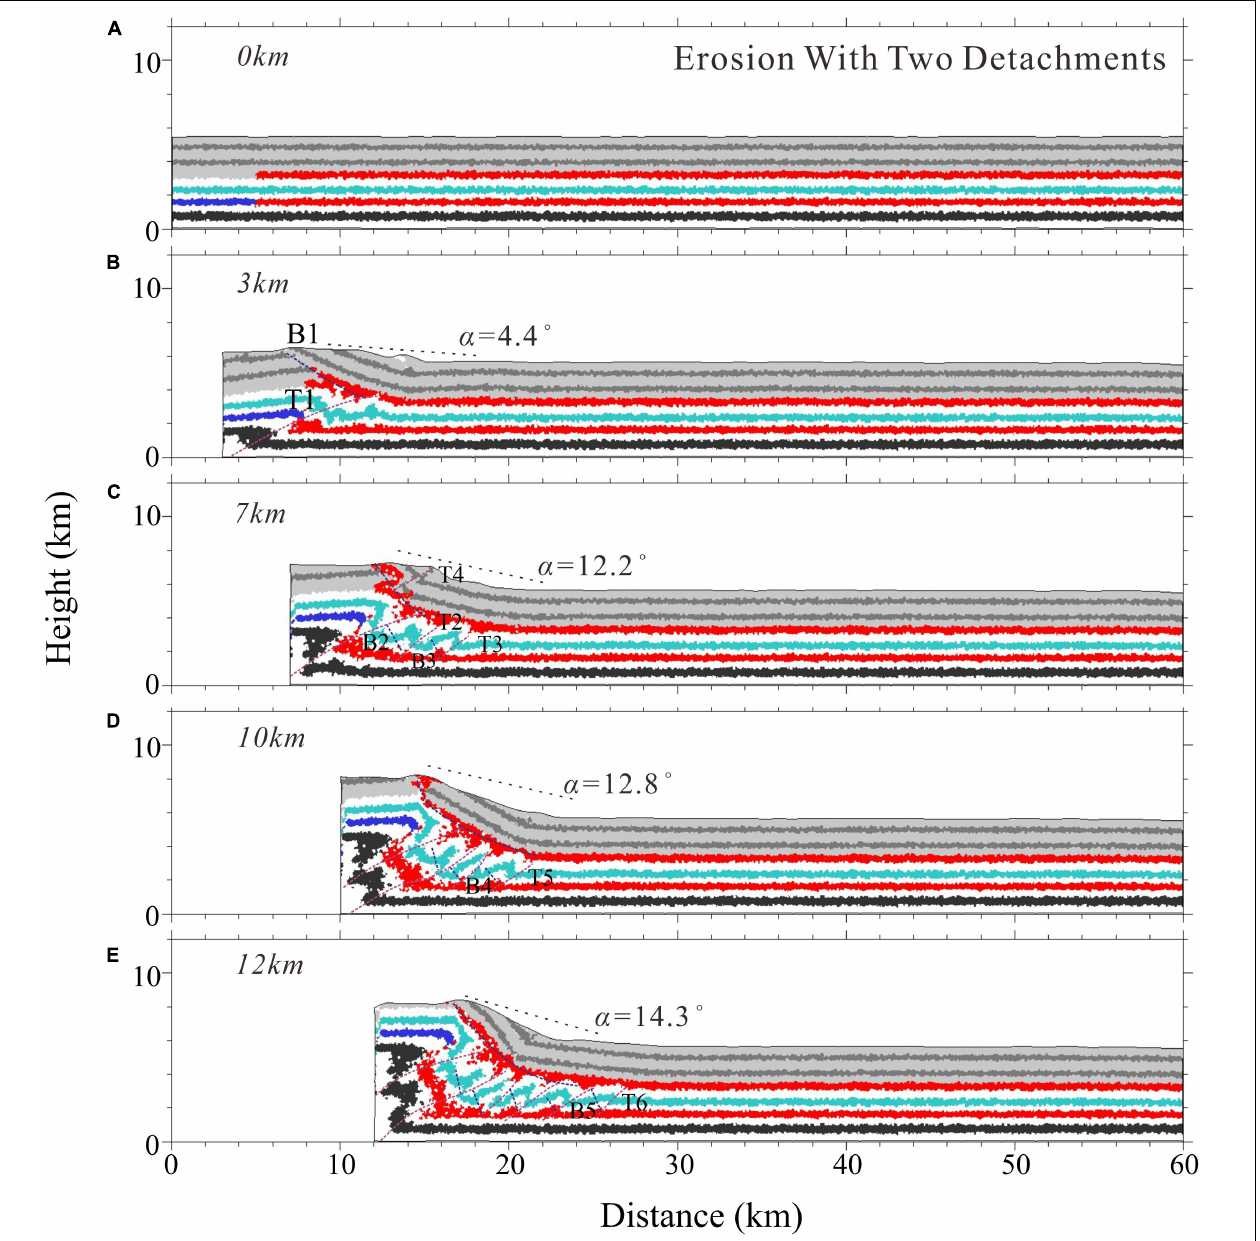
FIGURE 6 | Modeled progress with two detachments and erosions due to the left-wall displacement at shortenings of (A) 0 km, (B) 3 km, (C) 7 km, (D) 10 km, and (E) 12 km. T1–T6 and B1–B5 denote fore-thrusts and back-thrusts, respectively, in the order of their formation; α represents the current slope